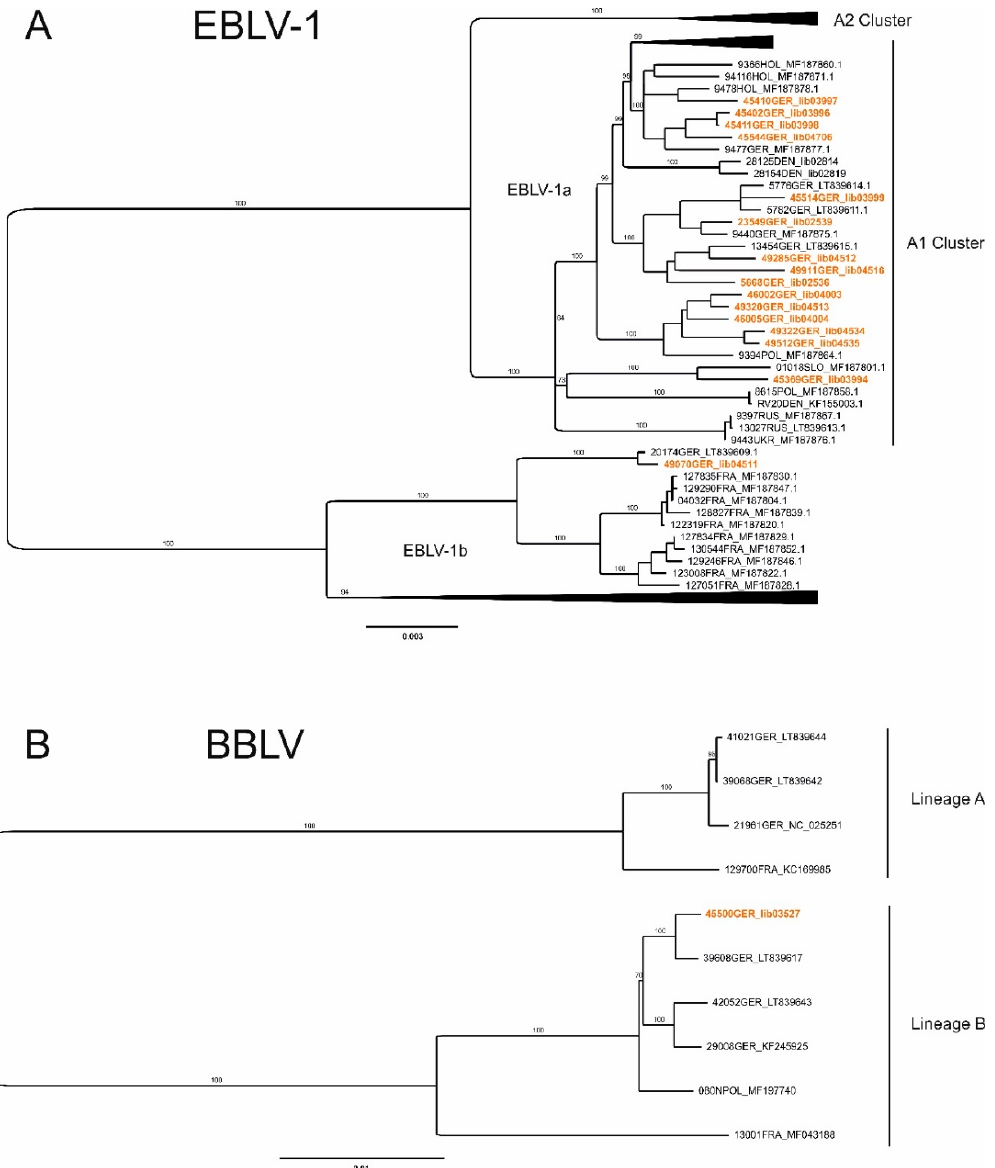
Figure 2. Mid-point rooted maximum-likelihood phylogenetic trees showing ( A ) the genetic diversity of 127 EBLV-1 full genome sequences originating from nine different countries, and ( B ) all available full genome sequences for BBLV. All newly generated full genome sequences (see Table 2) are indicated (orange).